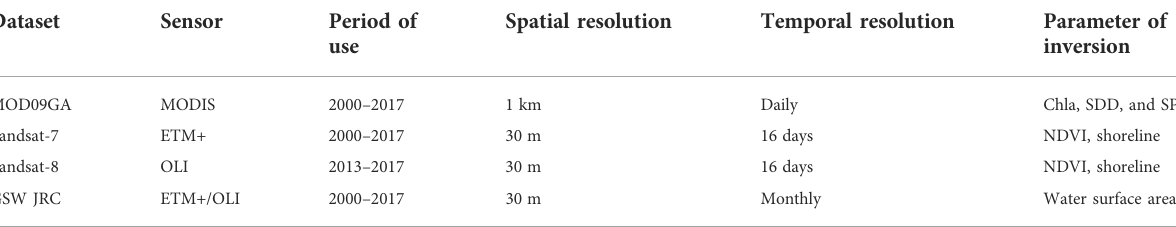
TABLE 1 Main remote sensing data employed in the